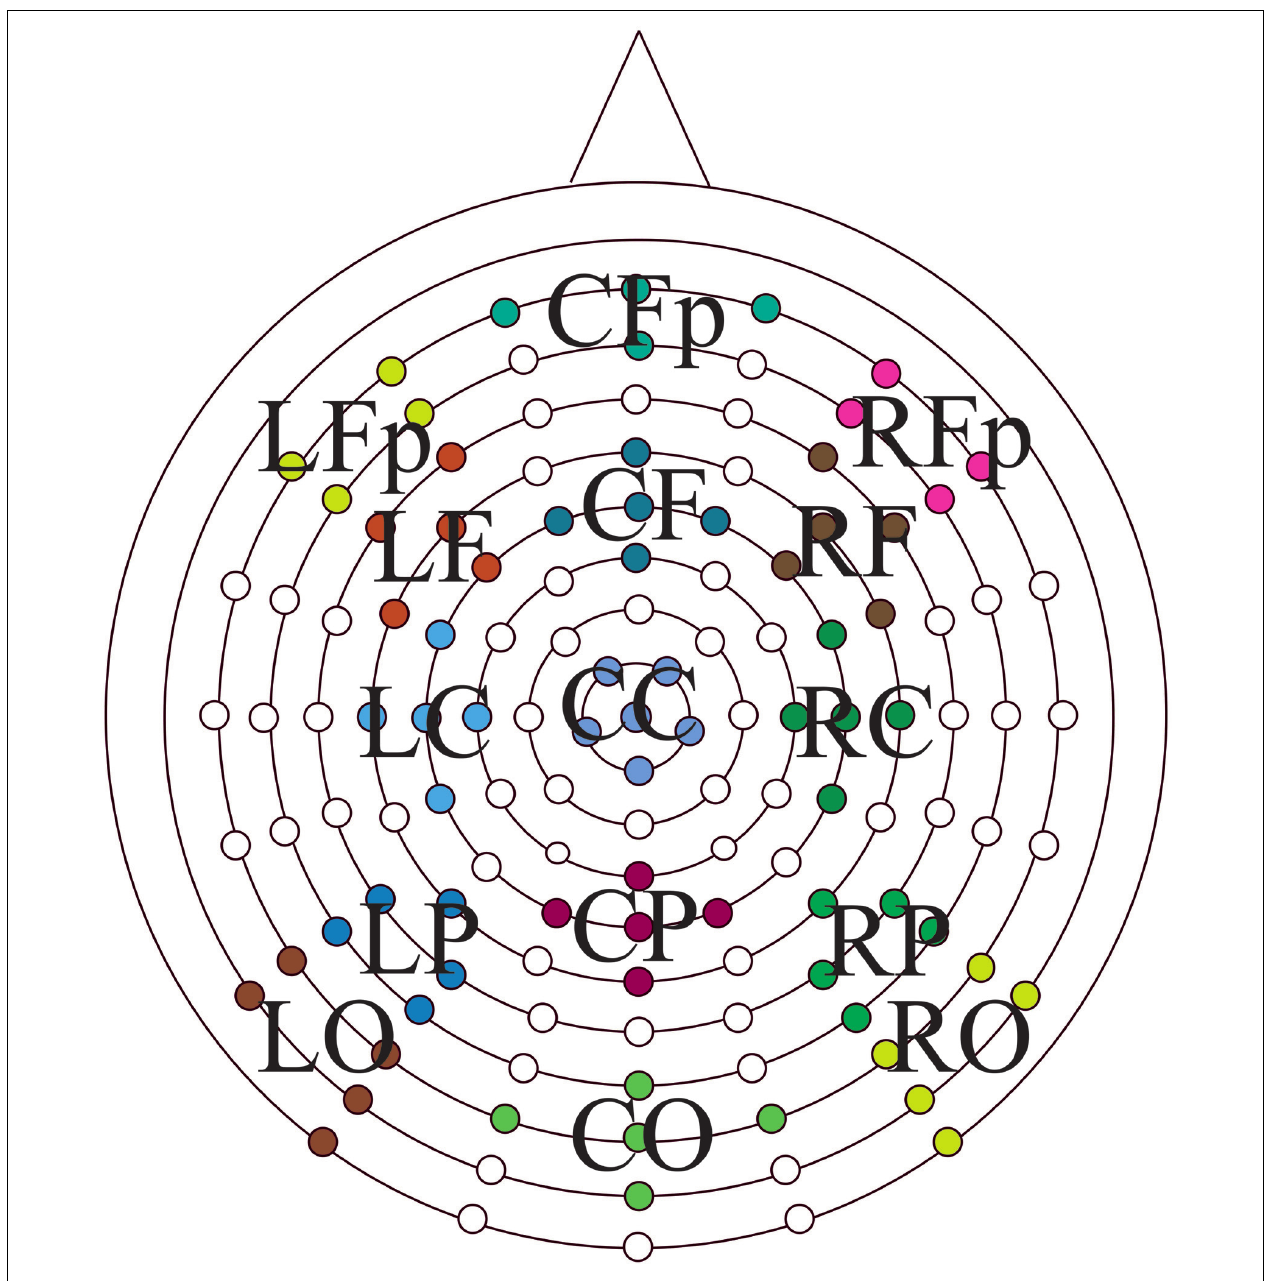
FIGURE 1 | Electrode positions on the Bio-SemiActiveTwo headcap with the 15 regions of interest displayed. Anterior-to-posterior: Fp, prefrontal; F, frontal; C, central; P, parietal; O, occipital central; left-to-right, L, left; C, midline; R,